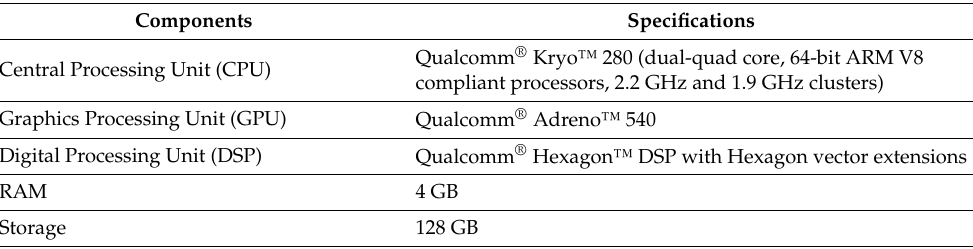
Table 4. Description of Snapdragon 835 mobile hardware development kit.